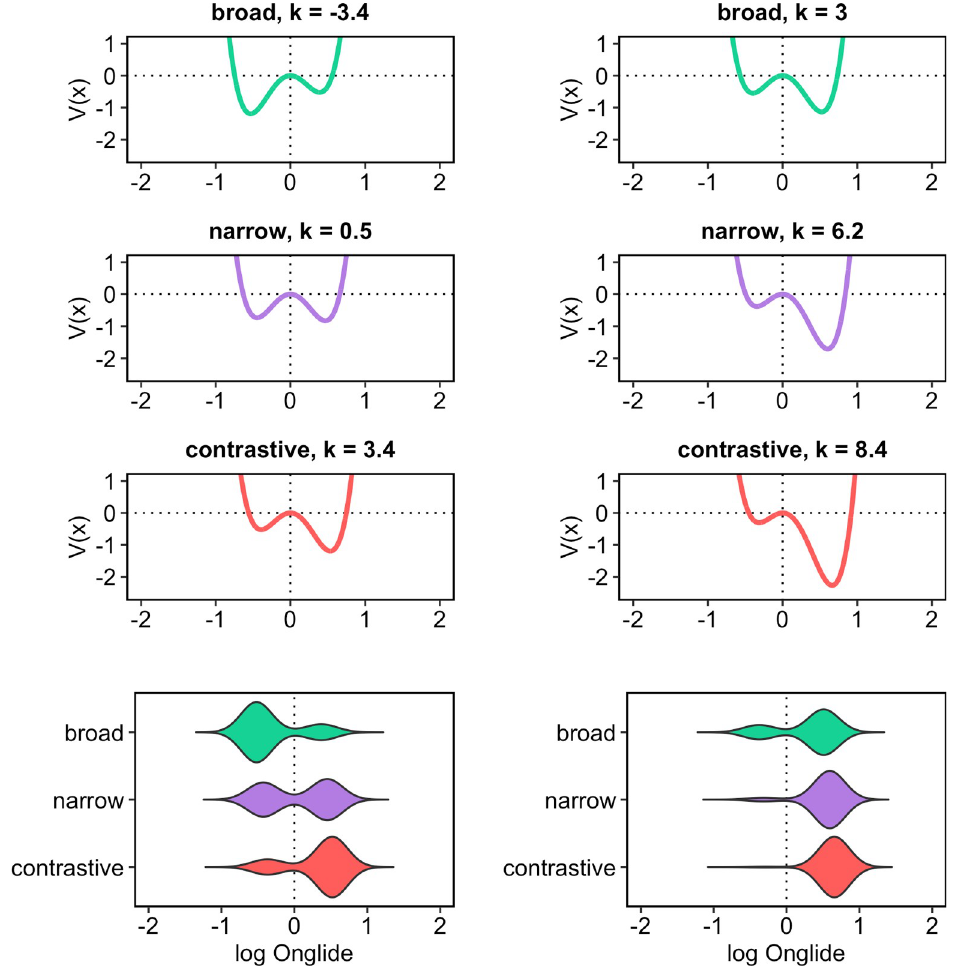
Fig 19. Attractor landscapes and simulated data for broad, narrow and contrastive focus with the best fitting values for the control parameter k. Group 1 on the left, group 2 on the right. The first three panels from the top show the potentials for the three focus types. The lower panel gives the simulation